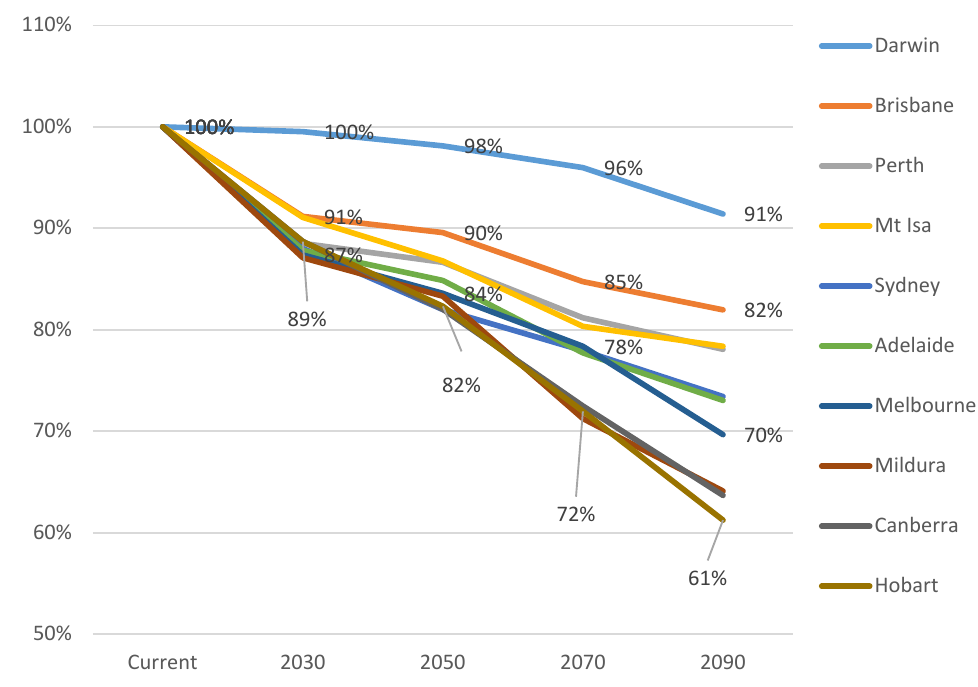
Figure 12. Large hospital’s boiler heating needs yearly benchmarking.